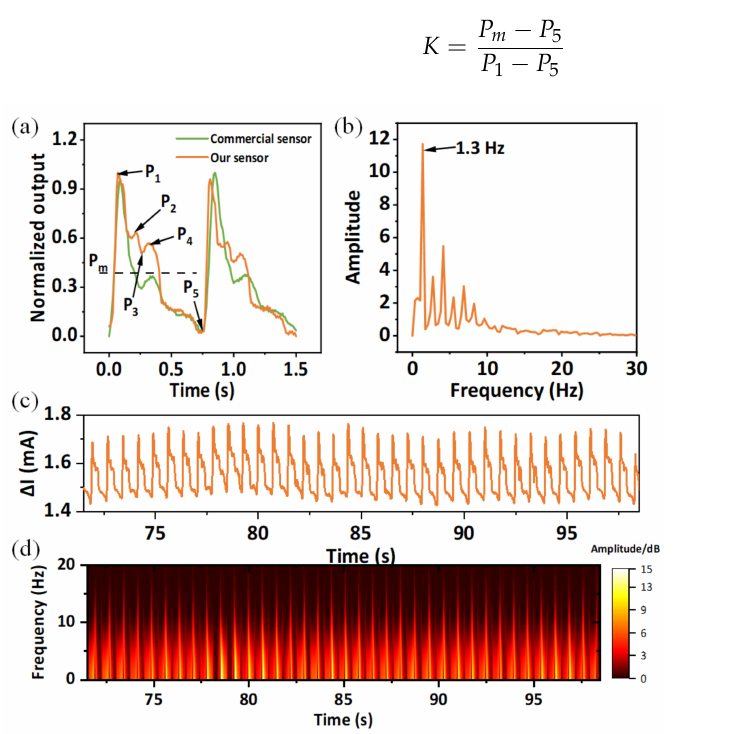
Figure 7. ( a ) Analysis and of RAPP waveform; ( b ) spectrum of ( a ); ( c ) long-term RAPP monitoring; ( d ) the STFE image of ( c